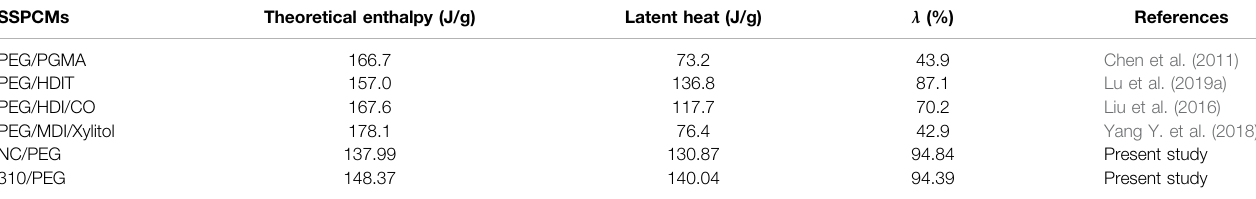
Thermal conductivity of sugarcane-based phase change materials.